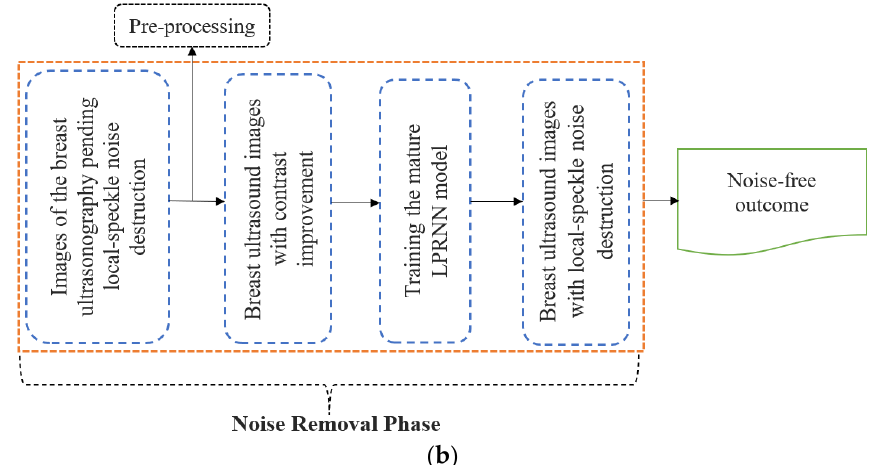
Figure 1. Local speckle denoising method for breast ultrasound images. Image segmentation separates objects from the backdrop. Object detection requires image segmentation. Noisy images are more problematic. Noises